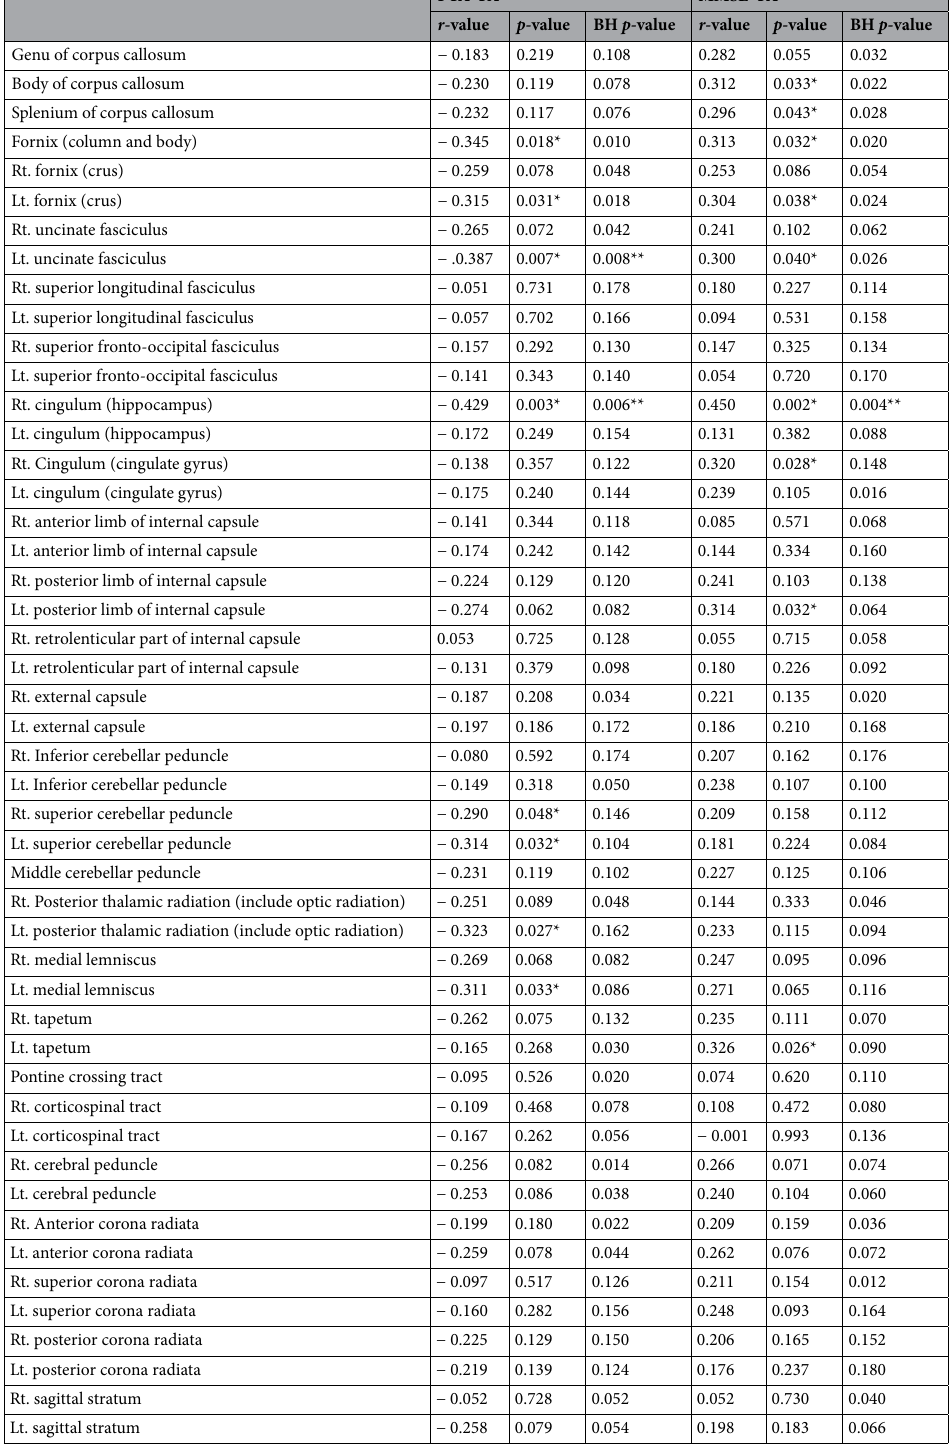
Table 3. Correlation between the post-traumatic amnesia duration and fractional anisotropy values and between mini-mental state examination score and fractional anisotropy values of the patient group. PTA post- traumatic amnesia, MMSE mini-mental state examination, FA fractional anisotropy. *Significant correlation between the post-traumatic amnesia duration and fractional anisotropy values, and the mini-mental state examination and fractional anisotropy values, p < 0.05. **Significant correlation between the post-traumatic amnesia duration and fractional anisotropy values, and the mini-mental state examination and fractional anisotropy values using a Benjamini–Hochberg (BH) correction; Values are means ± standard